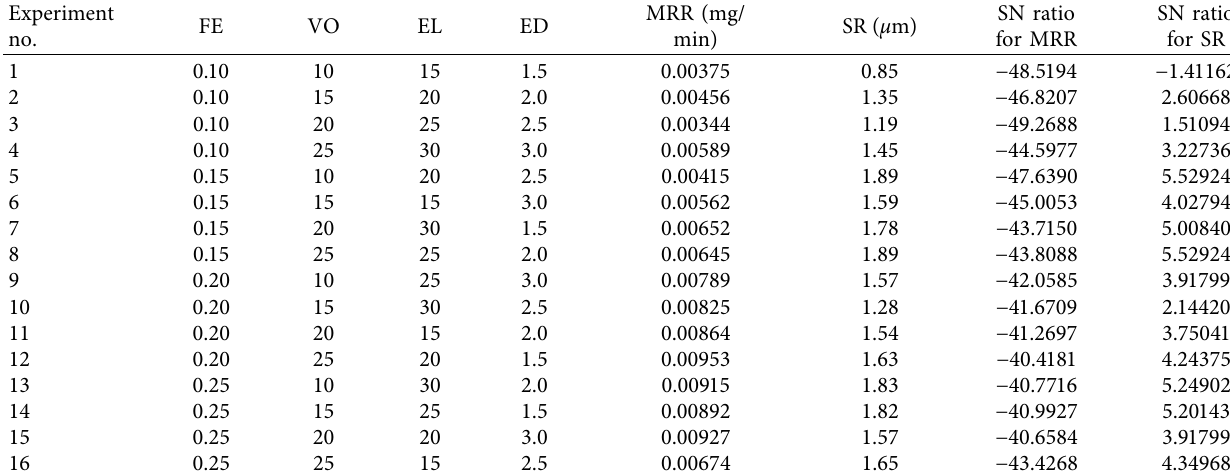
Table 5: Material removal rate results.